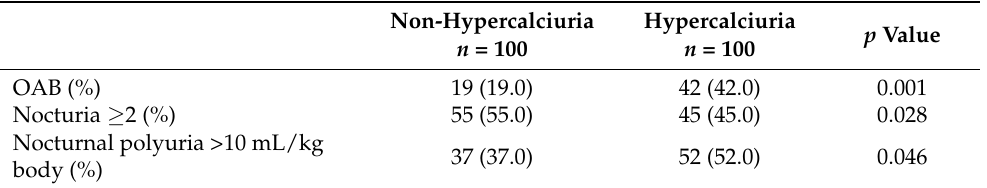
Table 6. Differences in lower urinary tract symptoms between the presence and absence of hypercal- ciuria based on propensity score matching